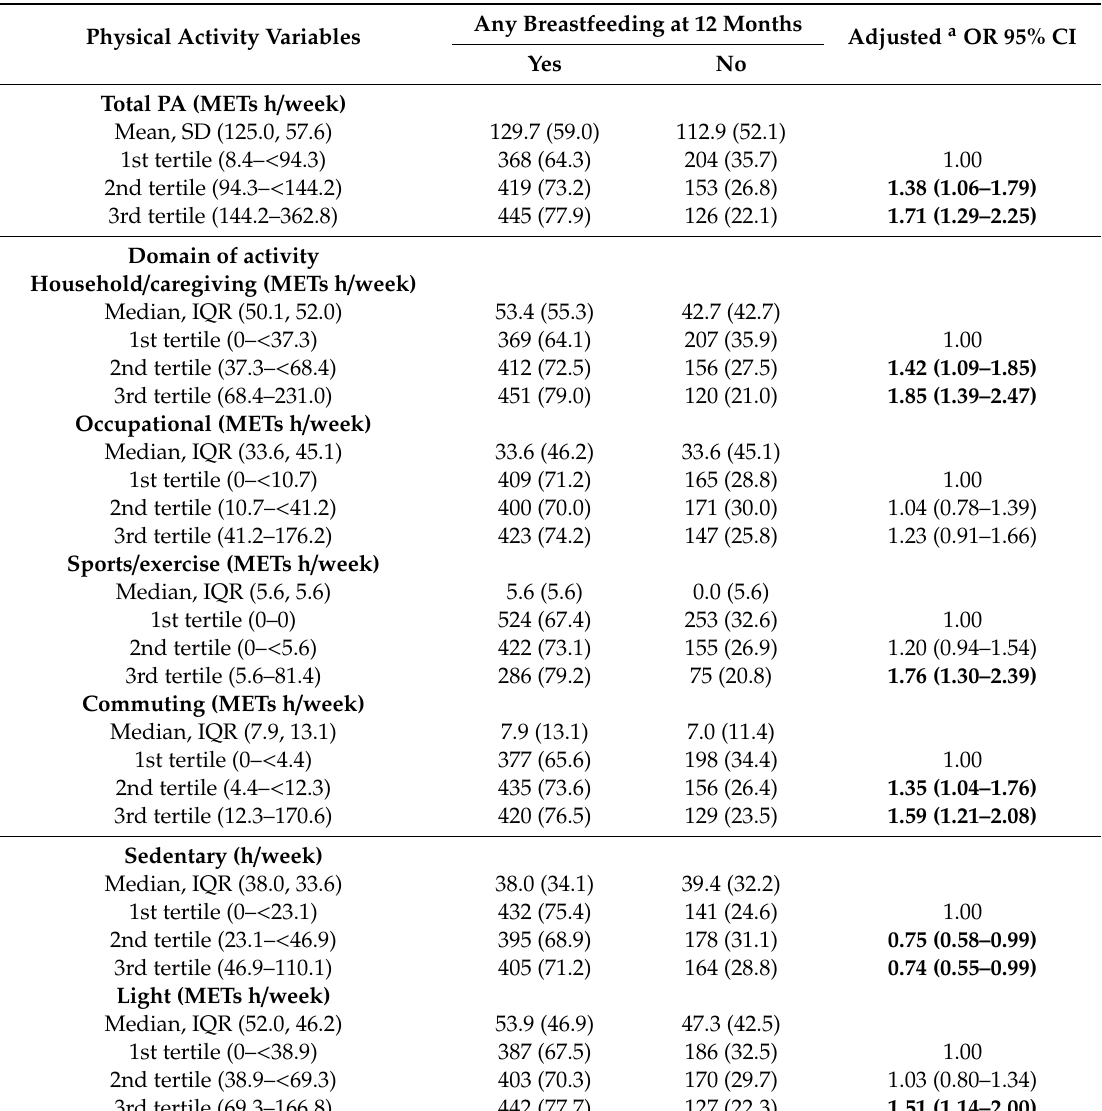
Table 2. Associations of levels of physical activity intensity and types during pregnancy with reported breastfeeding at 12 months among Vietnamese women ( N =